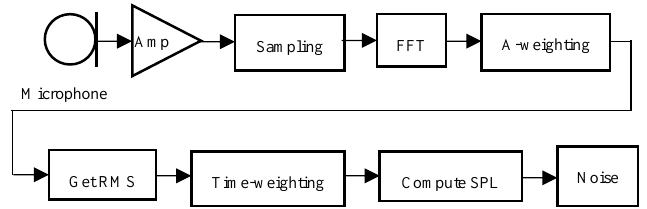
Figure 3. Flow chart of the sound pressure level (SPL) measurement unit.